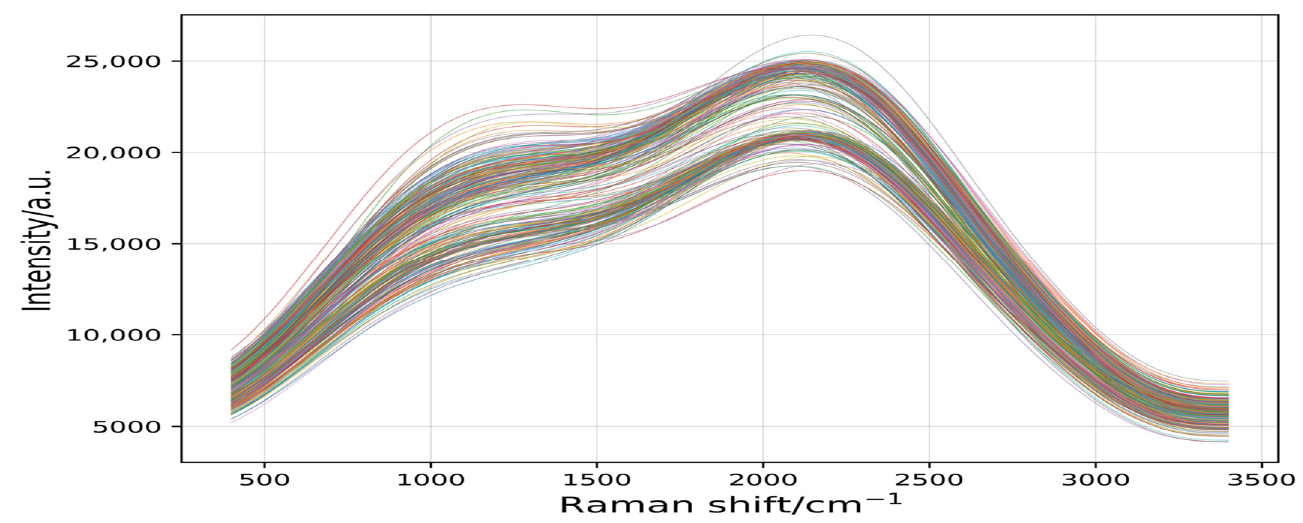
Figure 5. The 245 spectral curves were filtered by the signal.filtfilt function.